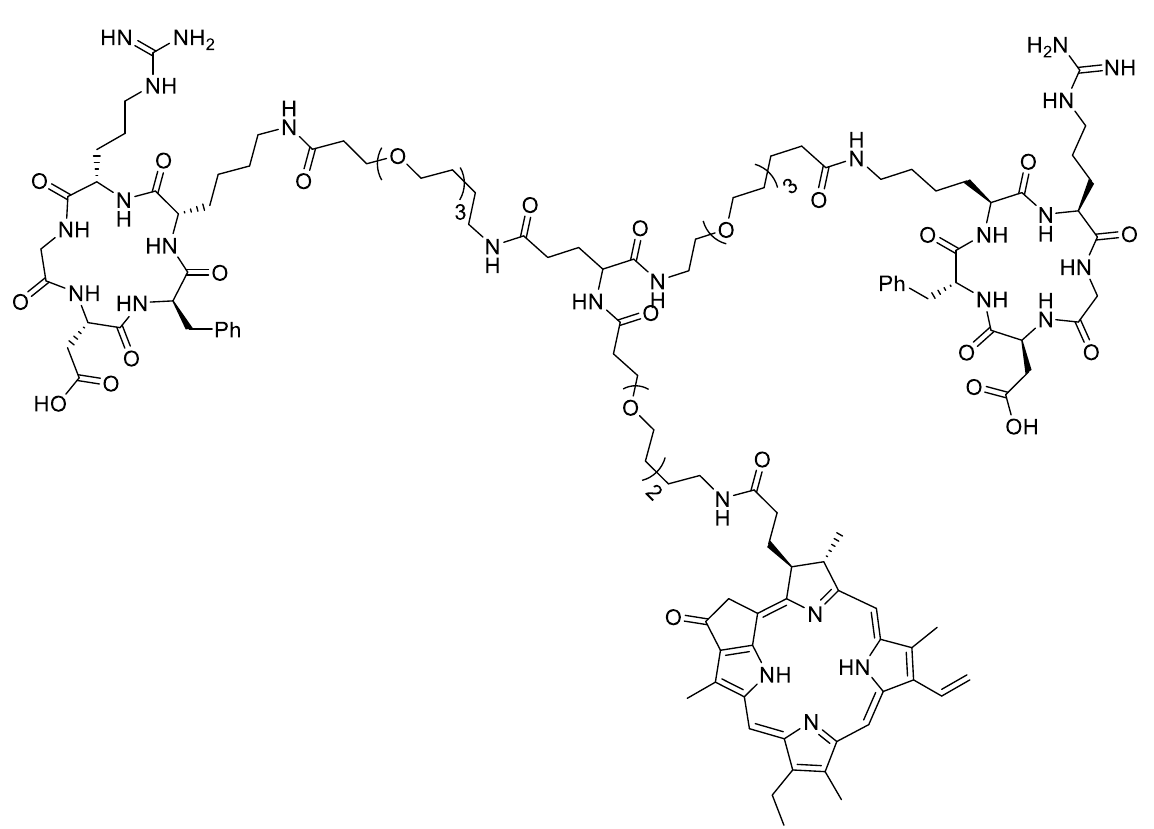
Figure 6. Structure of P3PRGD 2 = Pyro-3PEG 4 -E[c(RGDfK)] 2 .